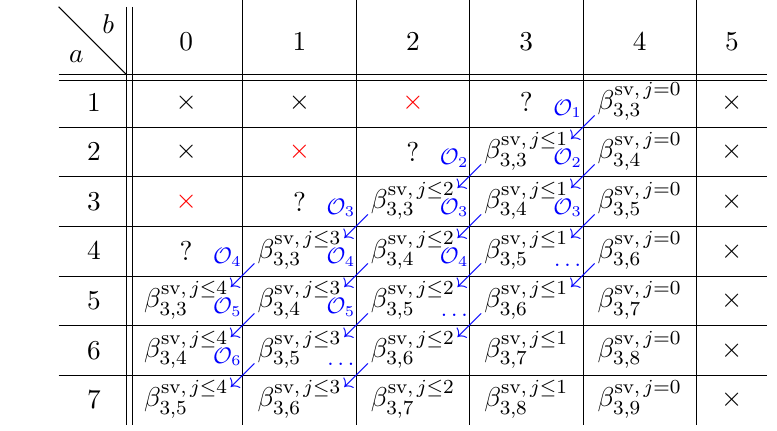
Table 1 . Leading-depth terms β sv ,j the action of the operators O